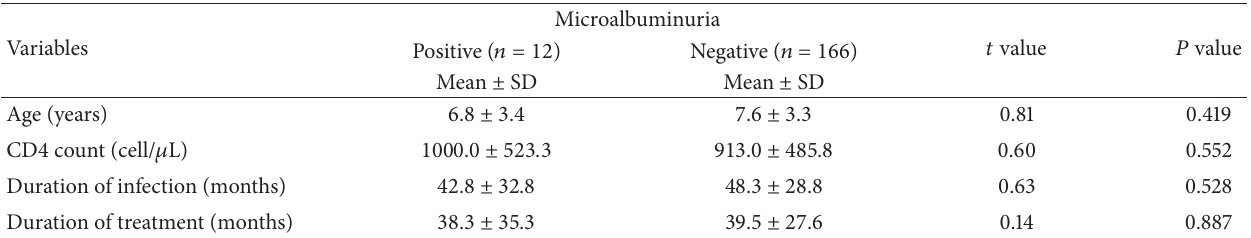
Table 7: Mean of various variables in participants with and without microalbuminuria.